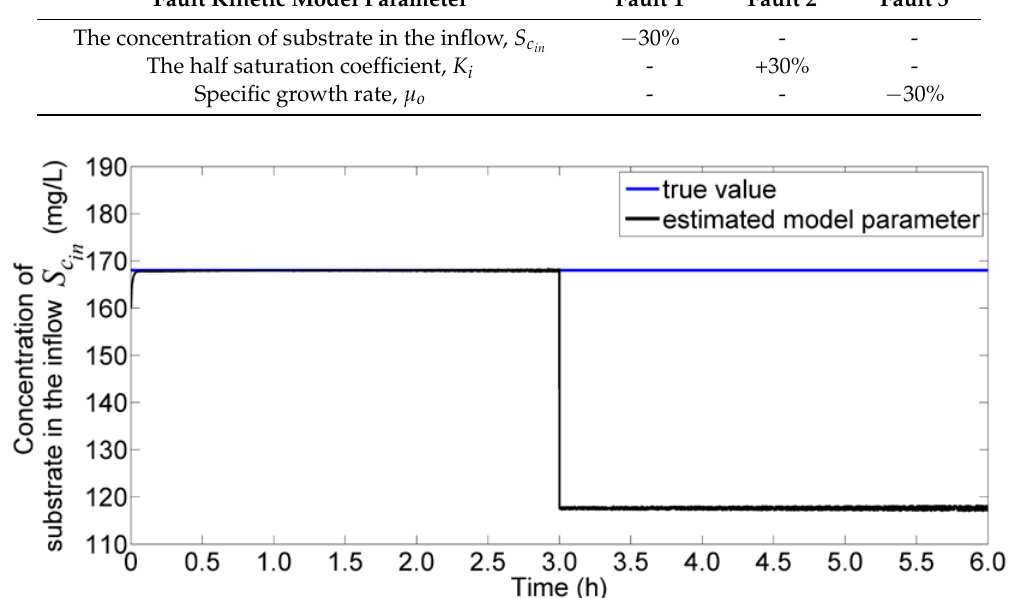
Figure 5. Estimated model parameter